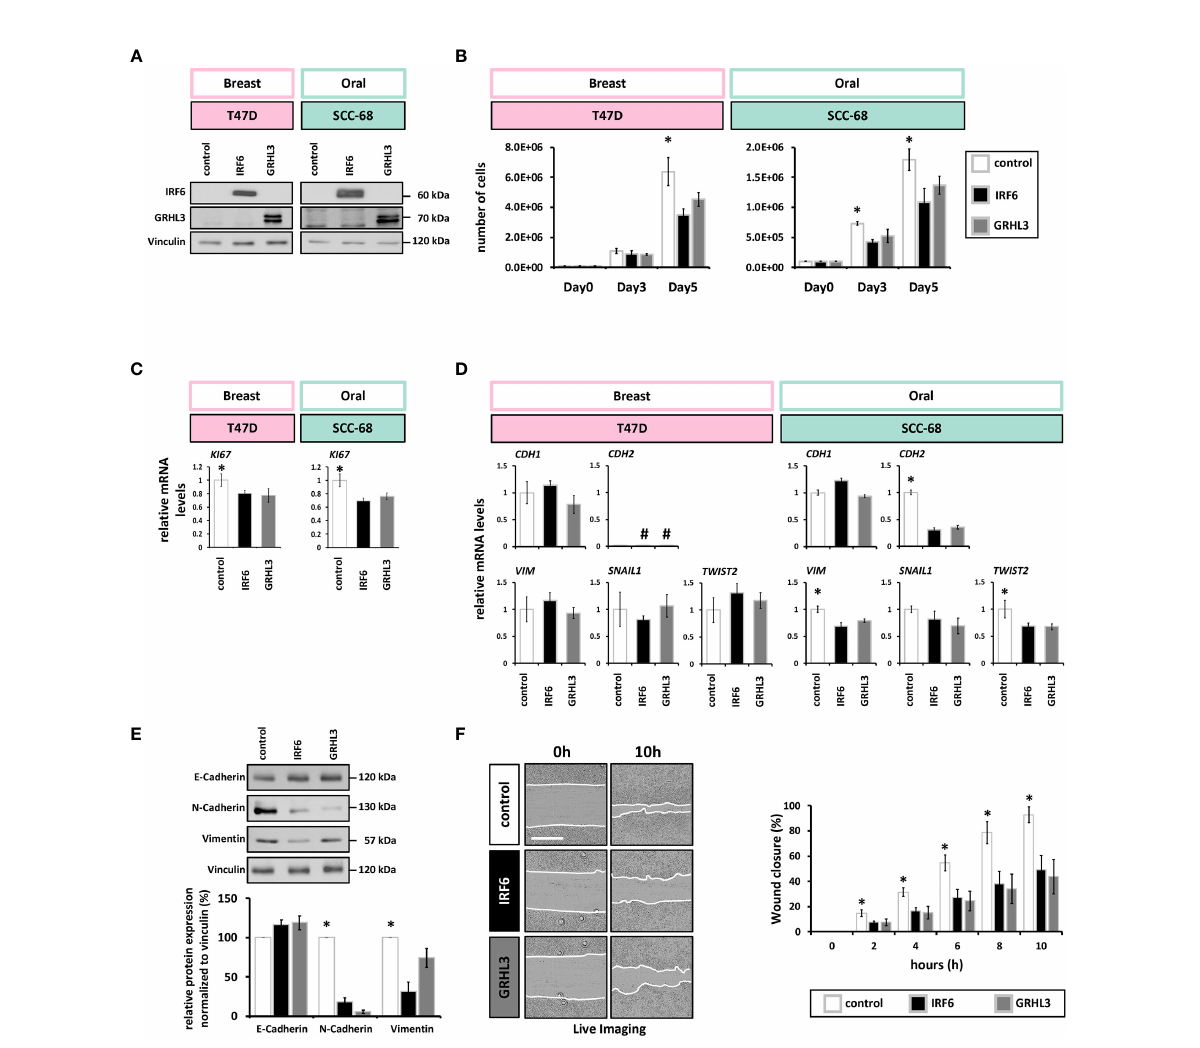
FIGURE 3 IRF6 and GRHL3 overexpression impairs cancer cell proliferation and migration (A) Immunoblots for IRF6 and GRHL3 con fi rming their overexpression. Full-length blots are shown in Supplementary Figure 6. kDa, kilo Daltons. (B) Cell growth of empty vector (white)-, IRF6 (black)-, and GRHL3 (gray)- transduced T47D (left) and SCC-68 cell lines (right) shows reduced number of cells by the enhanced presence of IRF6 and GRHL3. * p < 0.05 control vs. IRF6 and GRHL3 (C) qPCR analysis of the proliferation marker KI67 in transduced T47D and SCC-68 cell lines. * p < 0.05 control vs. IRF6 and GRHL3. (D) Transduced cells were analyzed for the expression of EMT markers CDH1 , CDH2 , VIM , SNAIL1 , TWIST2 . not detectable (cT > 32). (E) E-Cadherin, N-Cadherin, and Vimentin were analyzed by immunoblots in control and IRF6 and GRHL3 transduced SCC-68 cells. Quanti fi cation of the blots is shown below the immunoblots. * p < 0.05 control vs. IRF6 and GRHL3 for N-Cadherin and Vimentin. Full-length blots are shown in Supplementary Figure 6. kDa, kilo Daltons. (F) Representative live imaging pictures at t=0 h (left) and t=10 h (right) after scratching SCC68 control, SCC68/IRF6, and SCC68/GRHL3. White lanes indicate the migrating fronts on each side of the cell-free gap (left). Quanti fi cation of the closure of the cell-free gap is shown on the right. Note a signi fi cantly reduced migratory behavior of SCC-68/IRF6 and SCC-68/GRHL3 compared to control starting from t=2 h * p < 0.05 control vs. IRF6 and GRHL3. Scale bar: 500 µm. Movies of the various cell lines are shown in Supplementary Movies 1 –